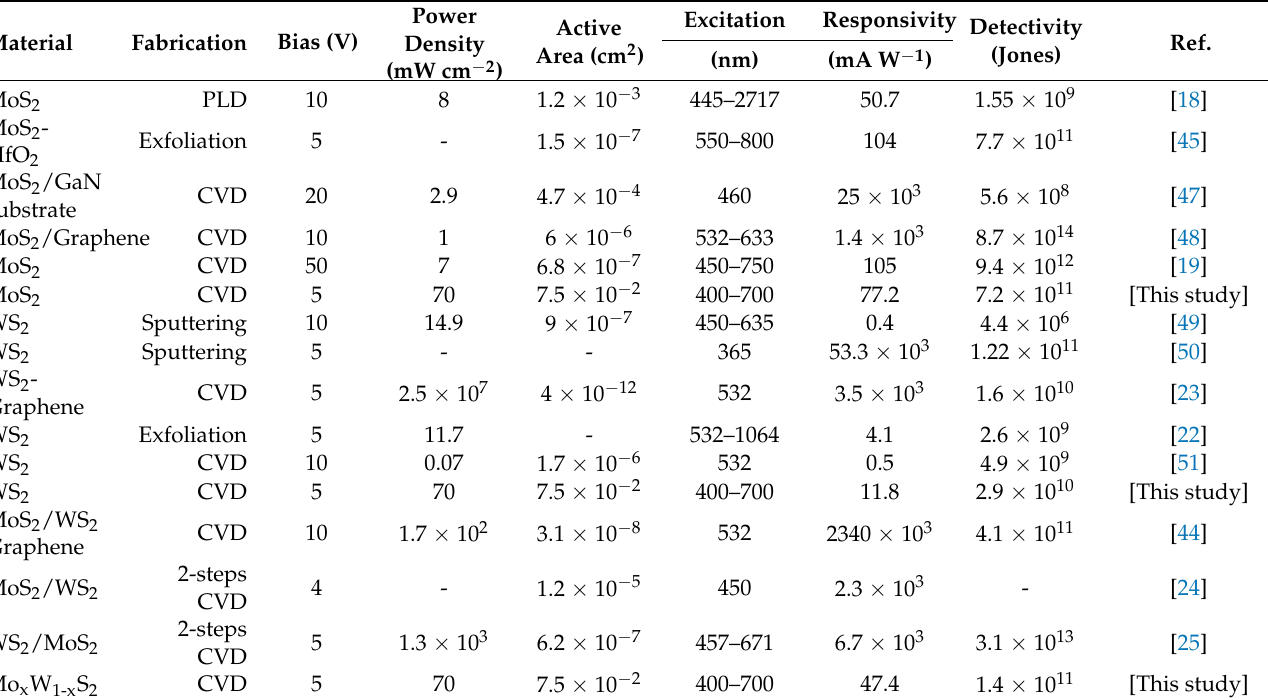
MoS 2 ; Figure S4: Bandgap computed using DFT simulations(a) direct bandgap for monolayer WS 2 , (b) indirect bandgap for bilayer WS 2 ; Figure S5: Bandgap obtained using Kubelka-Munck model (a) direct bandgap for monolayer WS 2 , (b) indirect bandgap for bilayer WS 2